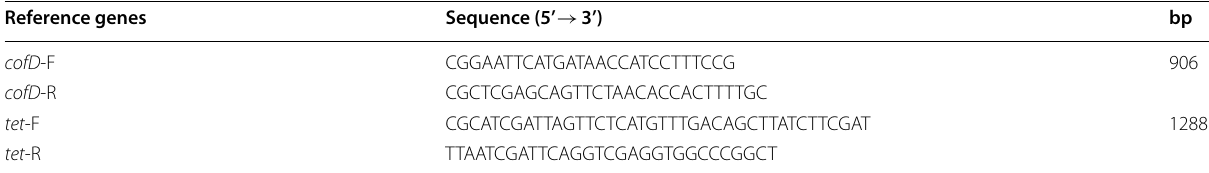
Table 1 List of reference genes and primers Reference genes Sequence (5’